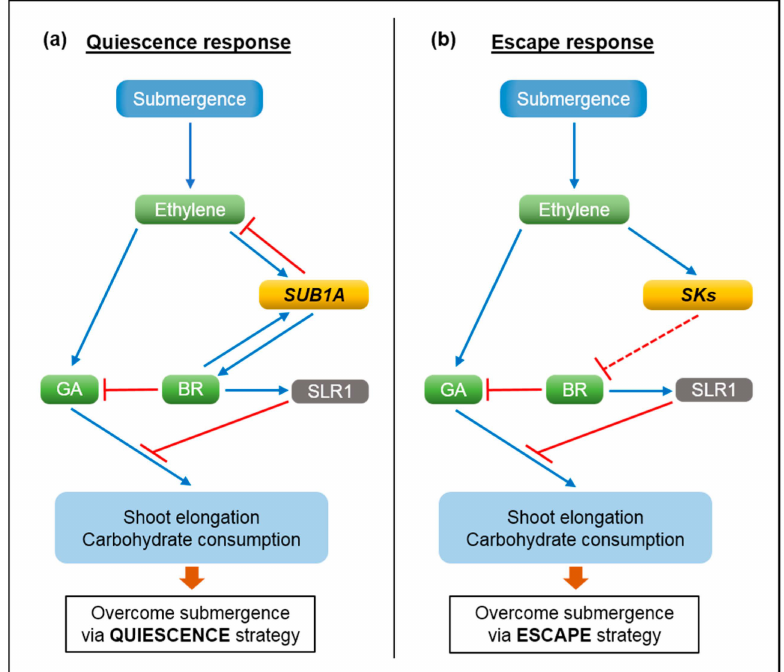
Figure 2. Model of the regulatory mechanisms underlying the quiescence and escape responses to submergence in rice. ( a ) Quiescence response: Under submergence, the level of endogenous ethylene quickly rises due to physical entrapment and increased biosynthesis, triggering mRNA accumulation of SUB1A [18]. SUB1A ultimately limits ethylene production, contributing to a reduction in ethylene-mediated GA biosynthesis. SUB1A also upregulates production of brassinosteroids (BR), promoting degradation of bioactive gibberellins (GA) and accumulation of SLR1, a negative regulator of GA signaling [21]. As a result, GA-mediated shoot elongation and carbohydrate consumption are suppressed in a SUB1A -dependent manner, enabling the avoidance of carbohydrate starvation and an energy crisis during submergence; ( b ) Escape response: Submergence-induced ethylene also increases the abundance of SNORKEL ( SK ) mRNAs [20]. It is anticipated that the regulatory role of BR in breakdown of bioactive GA and accumulation of SLR1 is conserved within O. sativa varieties. Based on the antithetical functions of SUB1A and SKs , upregulation of GA biosynthesis and responsiveness observed in deepwater rice [20,22,23] might be regulated via suppression of BR accumulation by SKs . This response allows deepwater rice to outgrow submergence water through GA-mediated internode elongation. Blue and red lines represent positive and negative regulation, respectively. A dashed line indicates a hypothetical